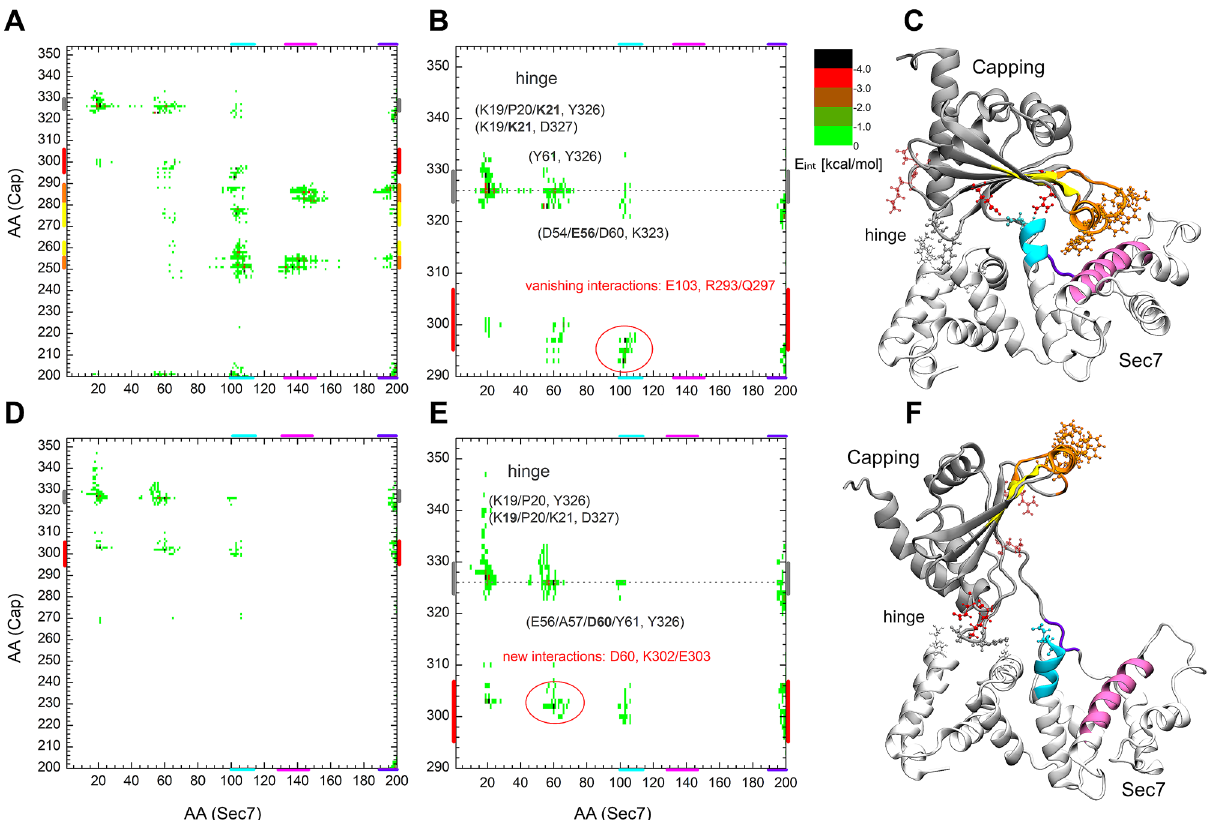
Figure 3. Interaction energy map between the residues of the Sec7 and the Capping domain of RalF in its autoinhibited, closed ( A ) and active, open state ( D ). Part ( B ) and ( E ) are enlarged views of A and D respectively, focusing on the hinge site. Part ( C ) of the figure shows the closed crystal structure and, ( F ) a modelled, open conformation of RalF. Structural regions of both domains color-coded along the axes of A and D are mapped with identical coloring onto the C and F part of the